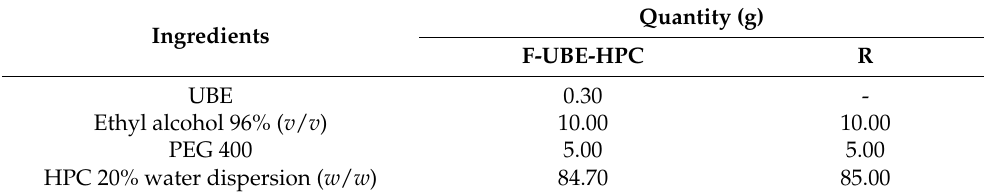
Table 1. Bioadhesive oral film